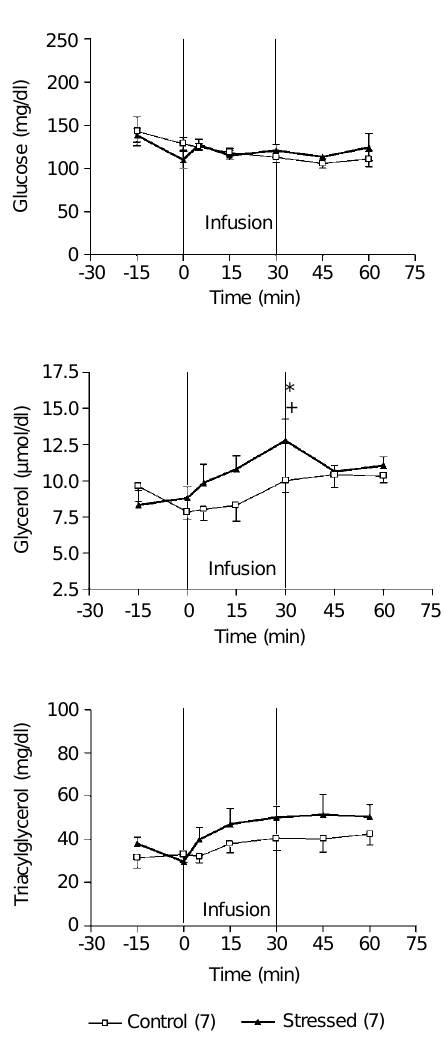
Figure 6. Effect of iv infusion of BRL 37344 (0.4 nmol kg -1 min -1 ) on plasma glucose, glycerol and triacylglycerol levels in fed con- scious rats after three daily ses- sions of confinement in foot- shock cages with no footshocks (control) or with footshock stress for 30 min. BRL 37344 infusion began 30 min after the end of the third session. The points represent the means ± SEM of the number of rats indi- cated in parentheses. + P<0.05 compared to the value at 0 min; *P<0.05 compared to the val- ues at 0, 5 and 15 min in the control group (ANOVA plus Tukey